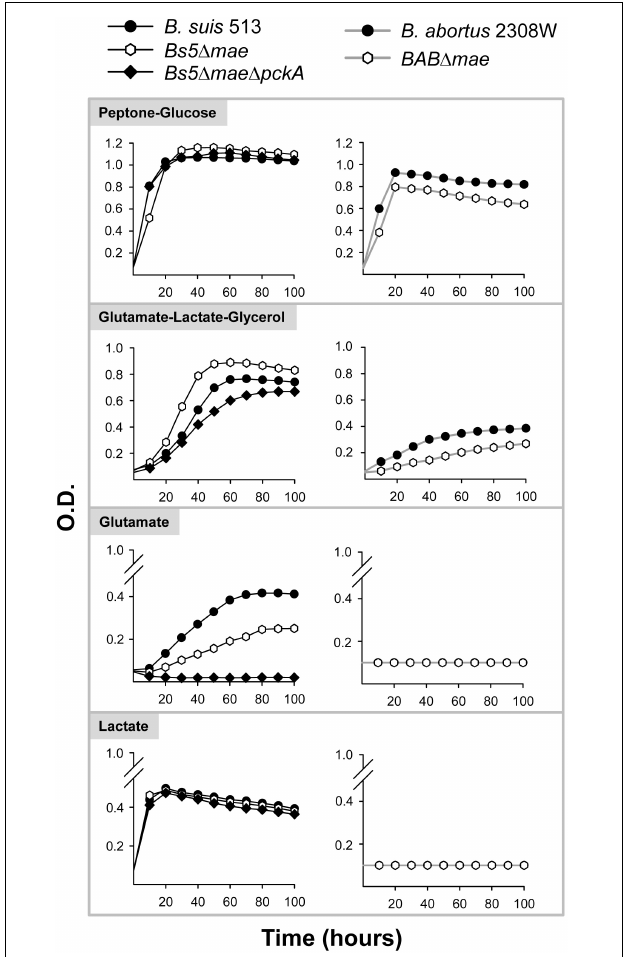
FIGURE 5 | Growth curves in peptone-glucose, glutamate-lactate-glycerol, glutamate, and lactate of B. suis 513 and mutants Bs5 (cid:49) mae and Bs5 (cid:49) mae (cid:49) pckA , and B. abortus 2308W and mutant BAB (cid:49) mae. Each point represents the mean ± standard error (error bars are within the size of the symbols) of an experiment performed in technical triplicates. The experiment was repeated three times with similar